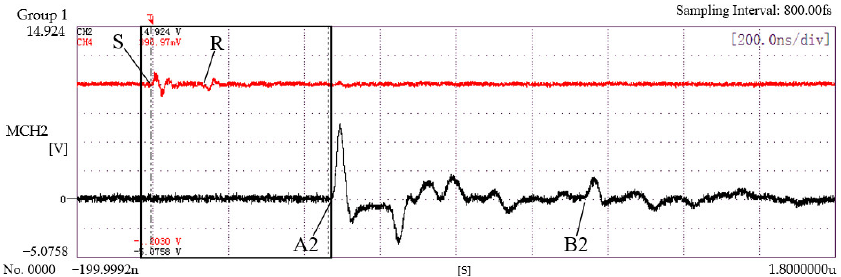
Figure 9. Dynamic strain characteristics of E690 high-strength steel under laser shock loading at a power density of 2.77 GW/cm 2 . power density of 2.77 GW/cm 2